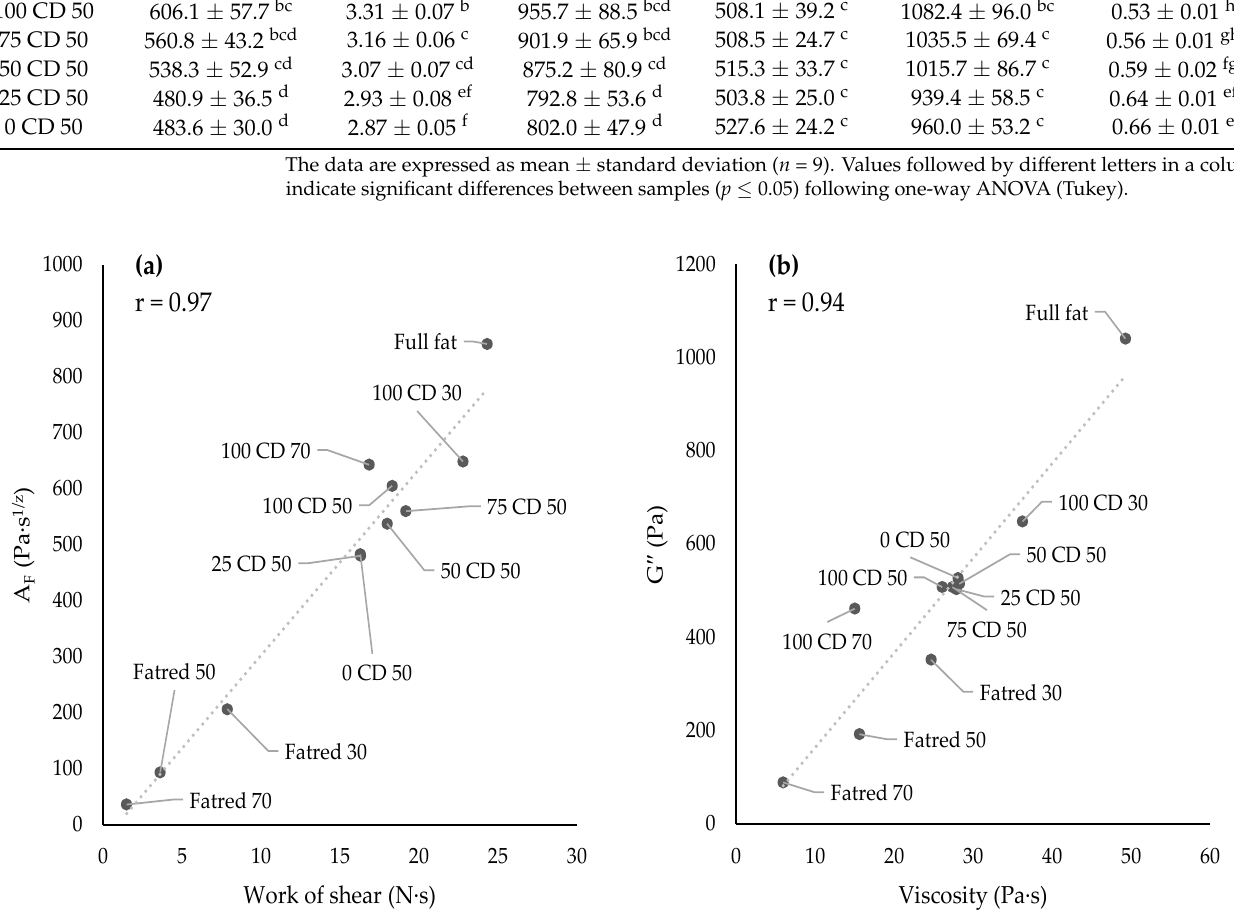
Figure 4. Correlation between work of shear (spreadability) and gel strength A F ( a ) as well as between loss modulus and viscosity ( b ) (r = correlation coefficient).